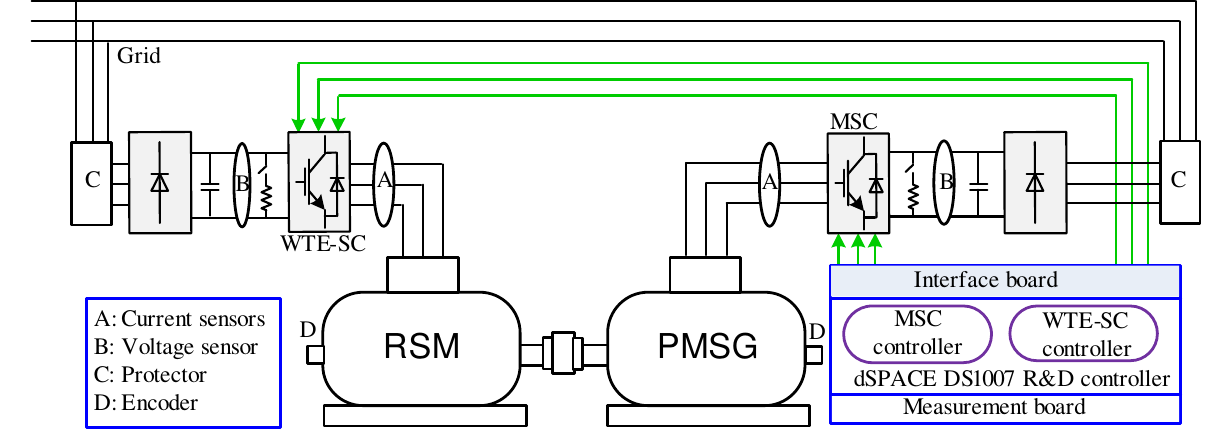
Figure 8. Schematic diagram of the laboratory setup for the